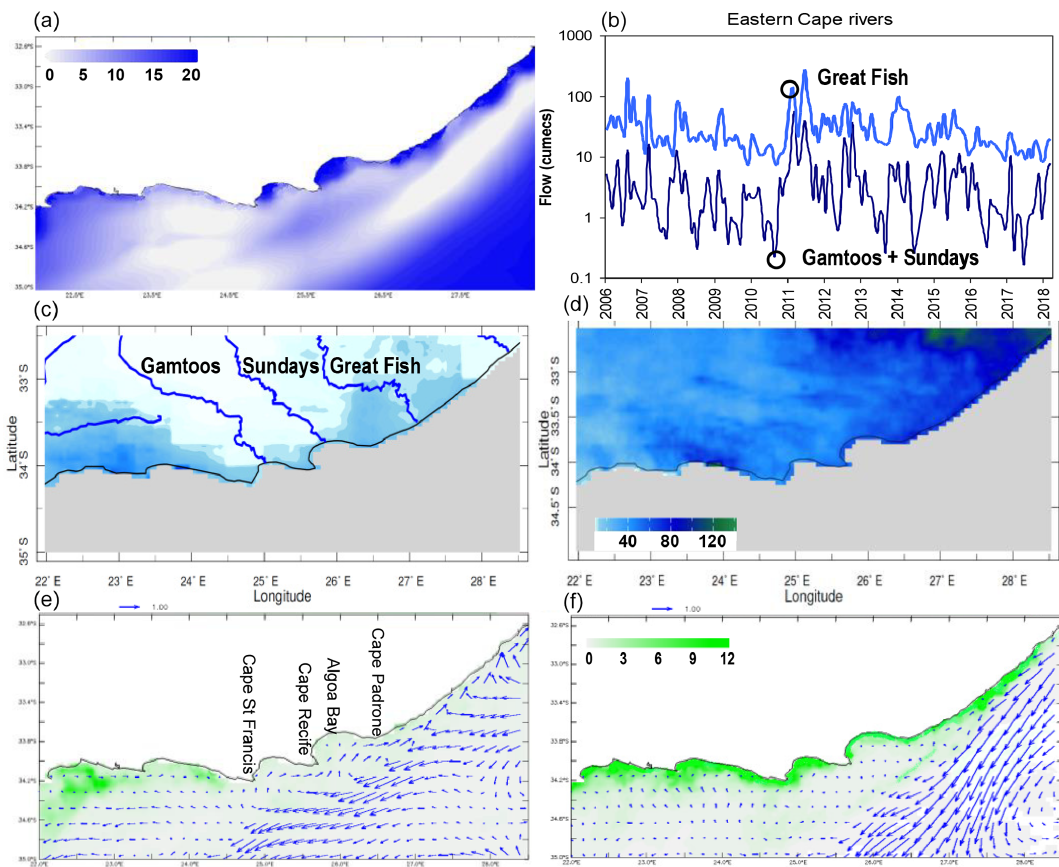
Figure 3. (a) Mean 2006–2017 HYCOM water flux into ocean (mmd − 1 ). (b) Observed monthly river discharge at the coast, with dry spell (1–10 August 2010) and wet spell (1–10 March 2011) (circled). (c, d) CHIRPS coastal rainfall (cumulative, mm), (e, f) MODIS chlorophyll (shading), and HYCOM near-surface current vectors during the dry spell (left) and wet spell (right). (c) Illustration of the main